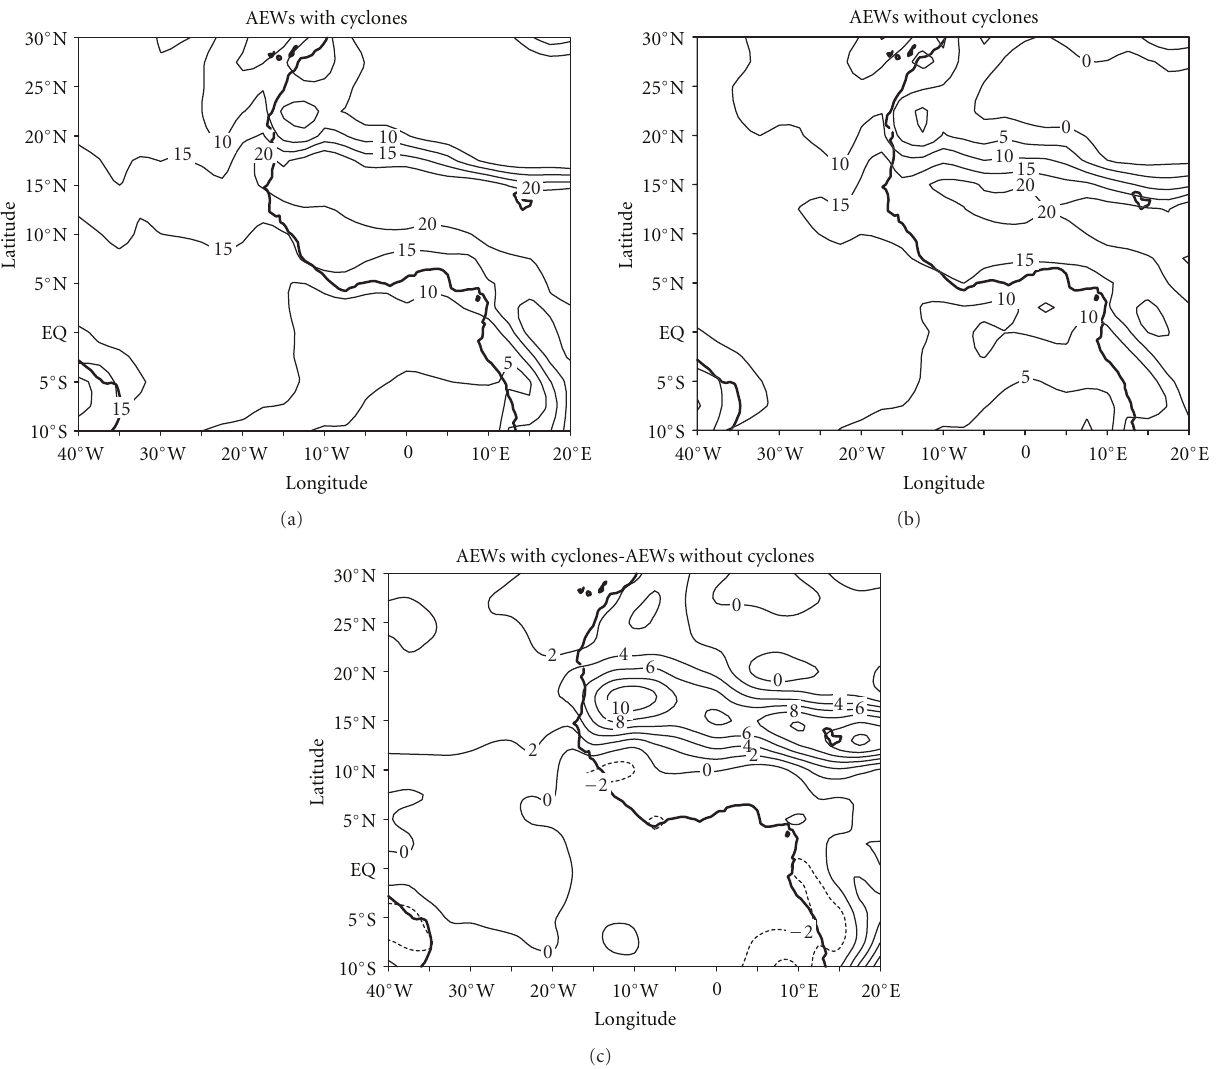
Figure 7: Potential of convection (K) for AEWs associated with cyclones (a), for non-developing AEWs (b) and the di ff erence between AEWs associated with cyclones and non-developing AEWs